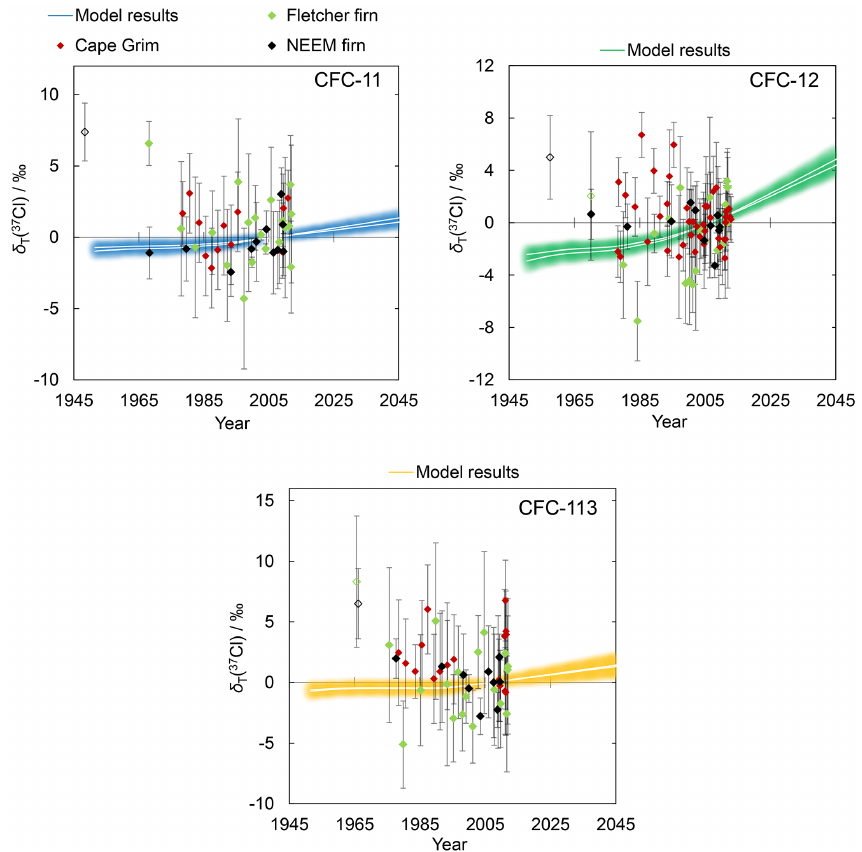
Figure 3. Tropospheric δ( 37 Cl) measurements, compared to model predictions. Black diamonds (NEEM firn air), green diamonds (Fletcher Promontory firn air) and red diamonds (Cape Grim air archive) represent the tropospheric chlorine isotope history of CFC-11, CFC-12 and CFC-113. The average repeatability for individual samples was ± 2.7‰ (CFC-11), ± 2.7‰ (CFC-12) and ± 3.8‰ (CFC-113). 1 σ standard deviation error bars are shown. Open symbols indicate that the measurement was subject to a small correction, based on instrumental nonlinearities (see Supplement). White trend lines represent model estimates of the temporal evolution of δ T ( 37 Cl) values. Two lines are displayed per species, one for each stratosphere–troposphere exchange flux estimate (Holton, 1990; Appenzeller et al., 1996). Blue (CFC-11), green (CFC-12) and orange (CFC-113) shading indicates the model uncertainty envelopes. These uncertainties are based on two independent sources of error: (1) the 1 σ uncertainty in ε app values; (2) the range of most likely lifetime values from SPARC (2013). All δ values are relative to an air sample collected in 2006 and the model output has been adjusted so that it passes through 0‰ at